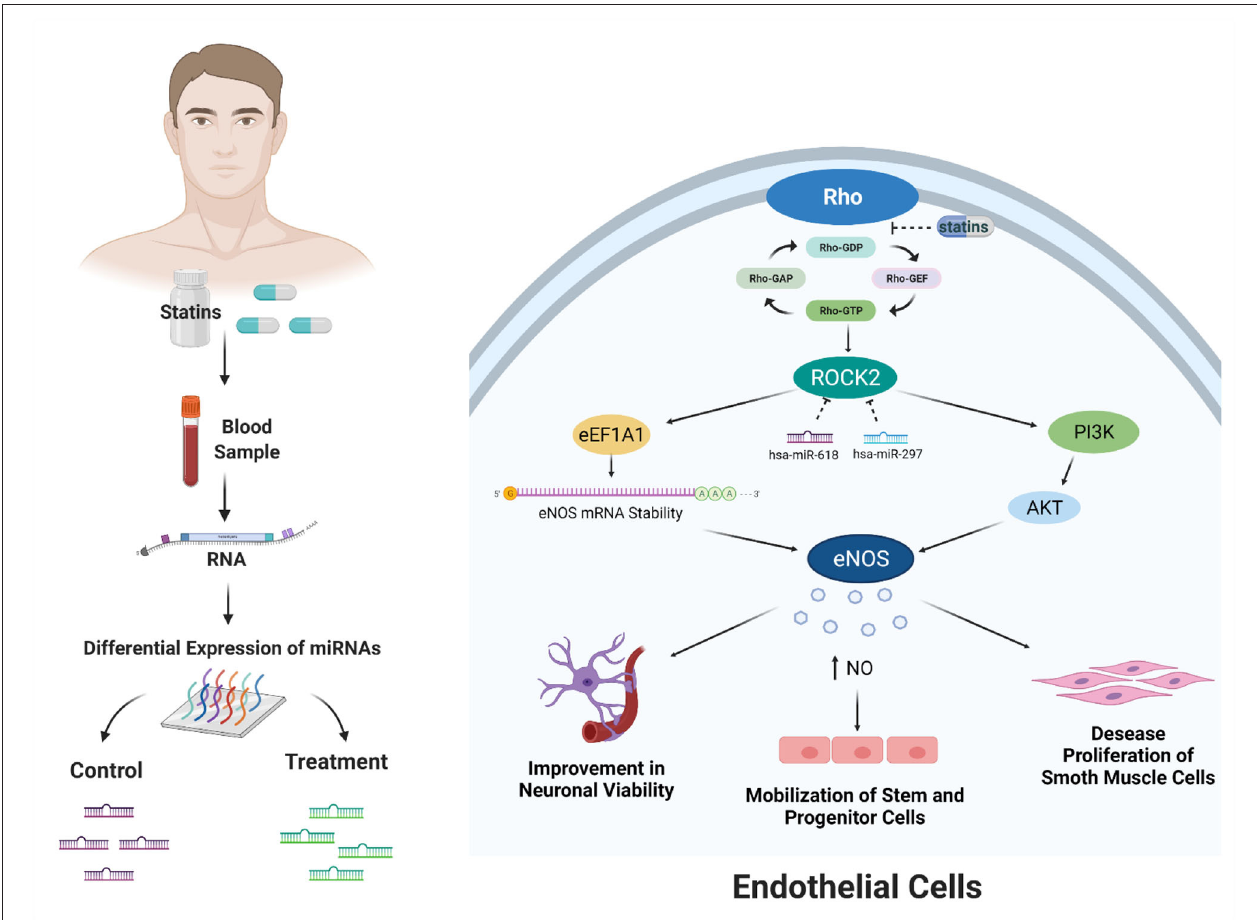
FIGURE 4 | Bioinformatic analysis showed that miRNAs modulated by statin treatment could exert the pleiotropic effects. These effects would occur due to the posttranscriptional inhibition of ROCK2 kinase by the miRNAs hsa-miR-618 and hsa-miR-297. ROCK2 kinase expression has been described by two mechanisms: stability of eNOS messenger RNA and increased activity by activation of phosphatidylinositol 3-kinase (PI3K)/AKT. The increased activity and expression of eNOS produce an increase in the bioavailability of NO. This effect of increasing NO affects improvement in neuronal viability, mobilization of stem and progenitor cells, and decreased proliferation of smooth muscle cells. Created with